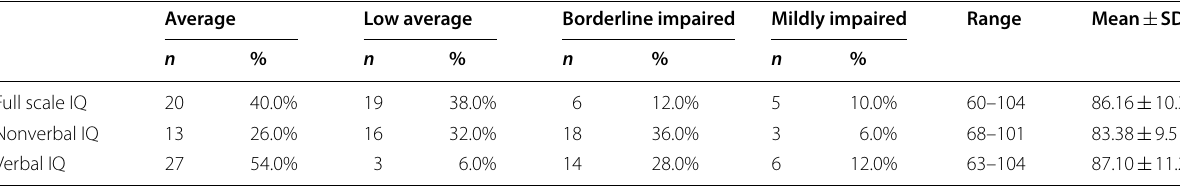
Table 3 Full scale IQ, non-verbal IQ and verbal IQ distribution among MS group ( n